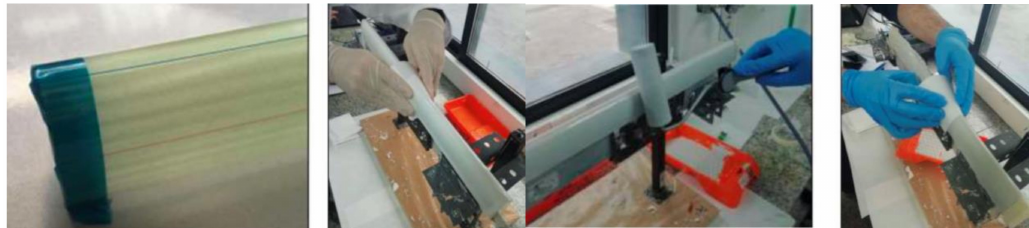
Figure 13. Reference multilayer configuration for RET coupons (DNVGL-RP-0171). Liquid droplet and each material layer are defined by the input mechanical parameters of Table 2.